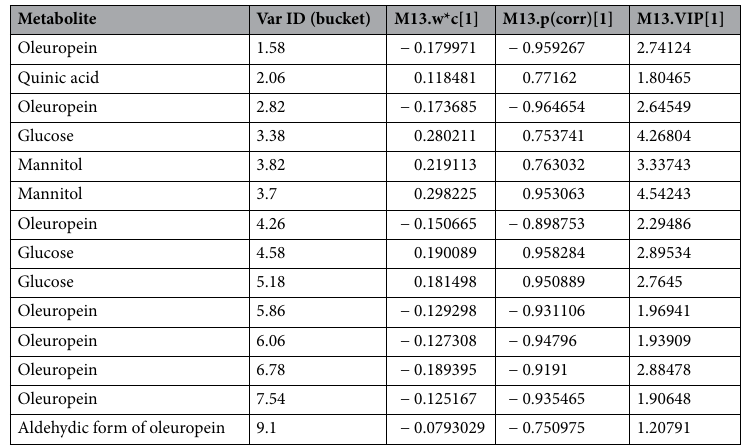
Table 2. List of discriminating chemical descriptors (variables) with corresponding weights (wc*), correlation coefficient (pcorr), and variable importance on the projection (VIP). (terms with VIP ≥ 1 have strong discrimination power).